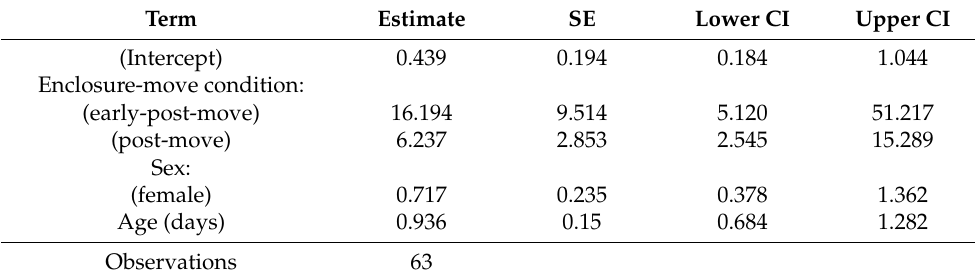
Table A13. Model 8 summary output: Effect of enclosure move on Malayan tapir